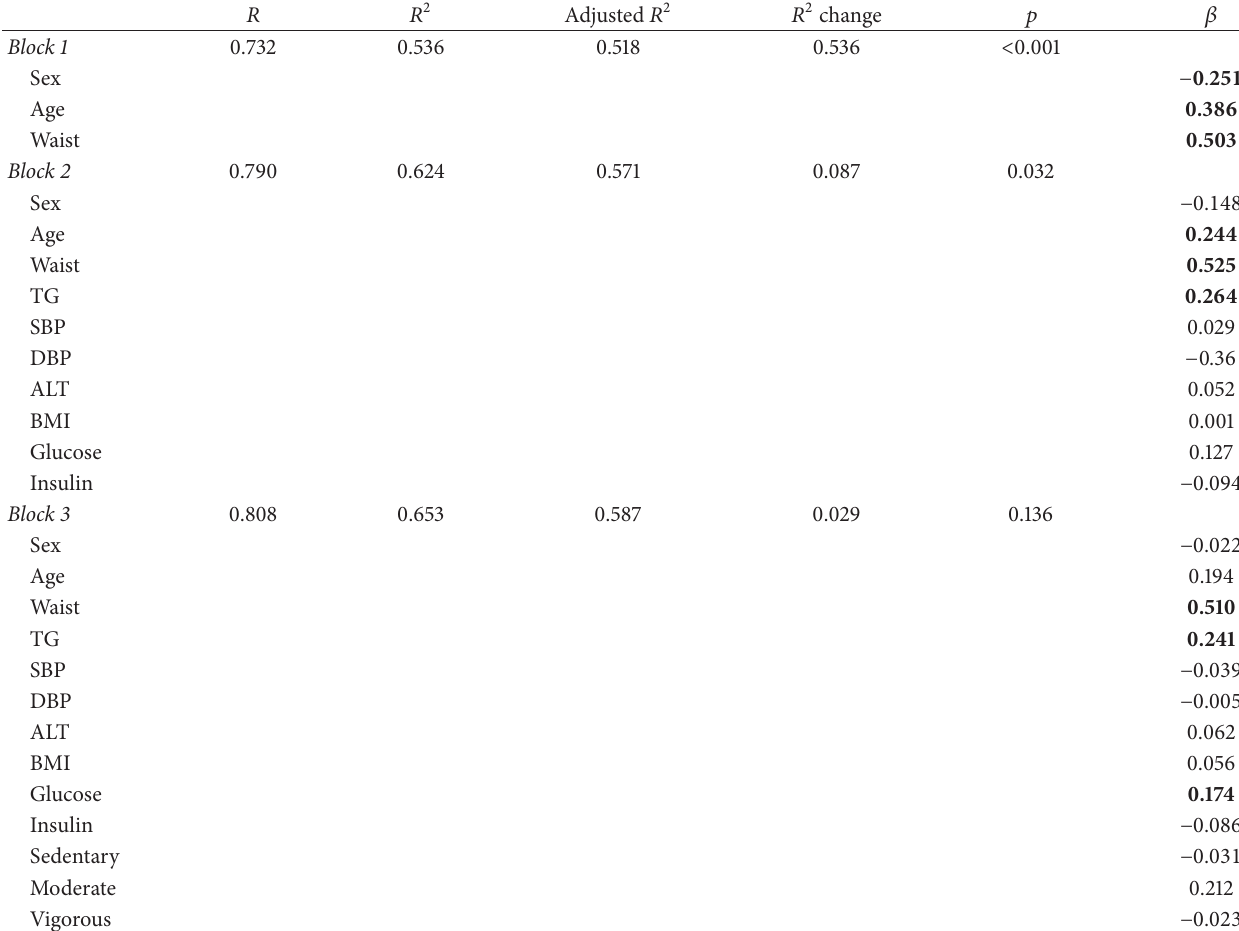
Table 3: Hierarchical regression model for prediction of visceral